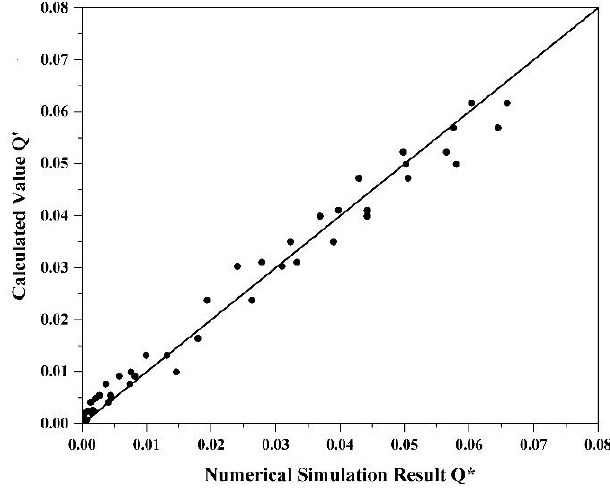
Figure 12. Comparison between the calculated value of the empirical formula and the numerical simulation result.